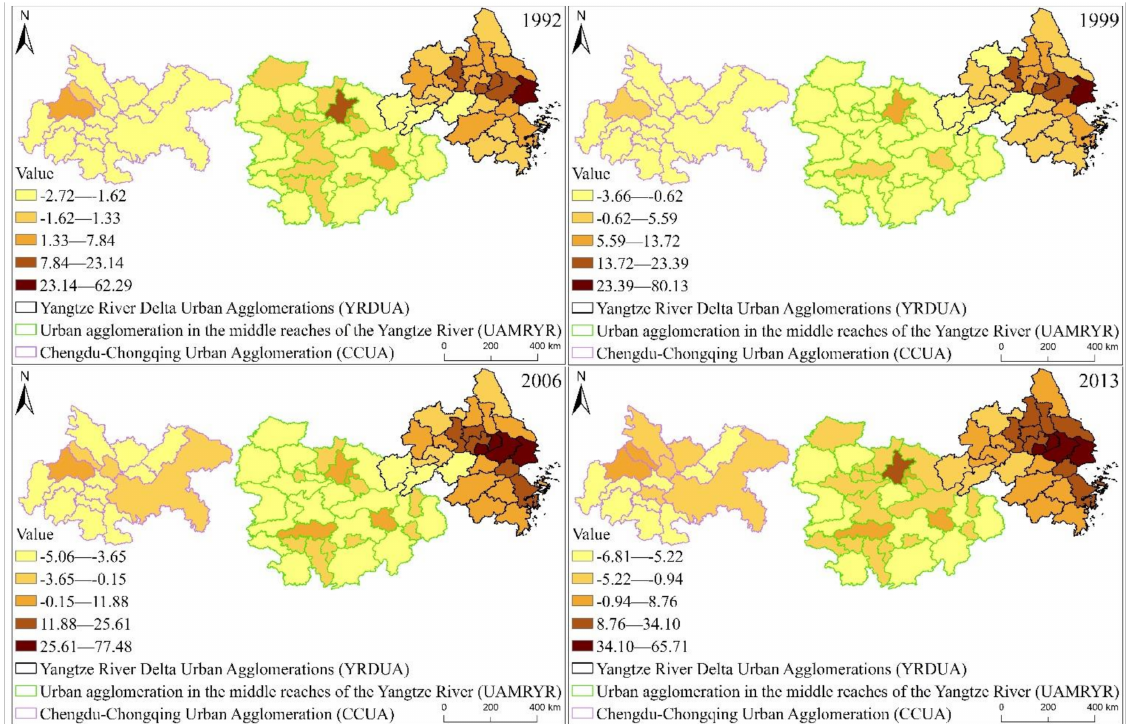
Figure 7. The distribution statistics of EPC cold and hot spots in the three major urban agglomerations of YREB from 1992 to